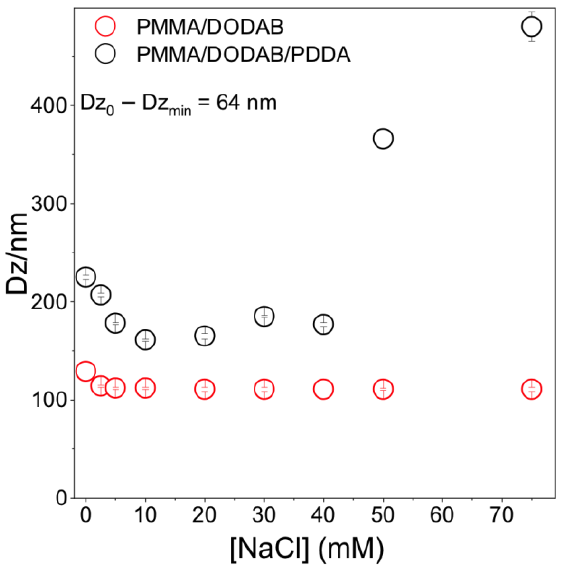
Figure 3. Effect of [NaCl] on PMMA/DODAB/PDDA or PMMA/DODAB NPs Dz. At [NaCl] = 0, Dz 0 =225 ± 2 nm. At 10 mM NaCl, Dz min =161 ± 1 nm yielding 161 ± 1 nm core and 64 nm shell.